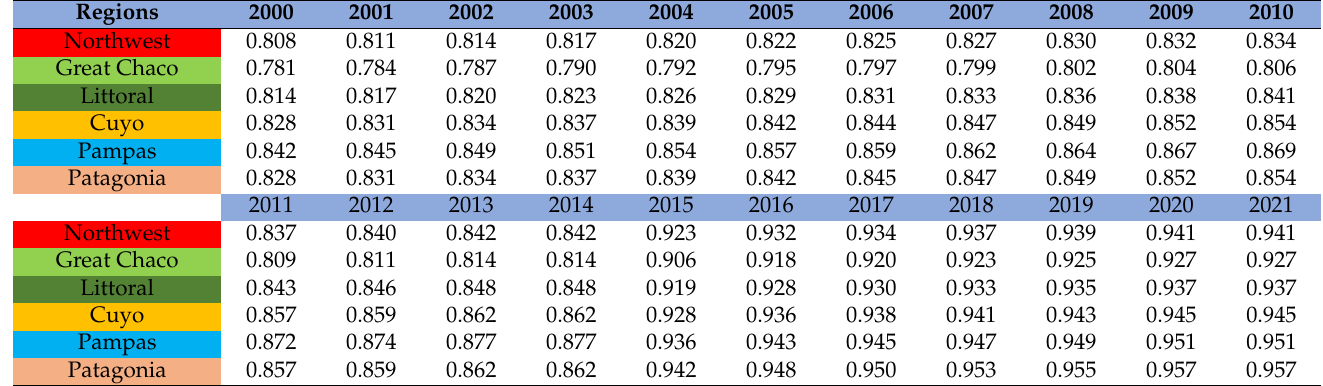
Table 10. Estimated life expectancy index–Argentina 2000–2021.